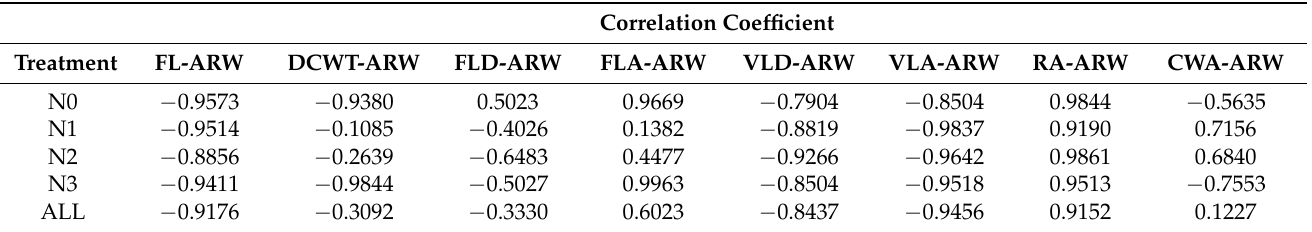
Table 6. Correlation coefficients of the annual ring width and anatomical properties of the juvenile wood of the clone ‘Villafranca’ during and after